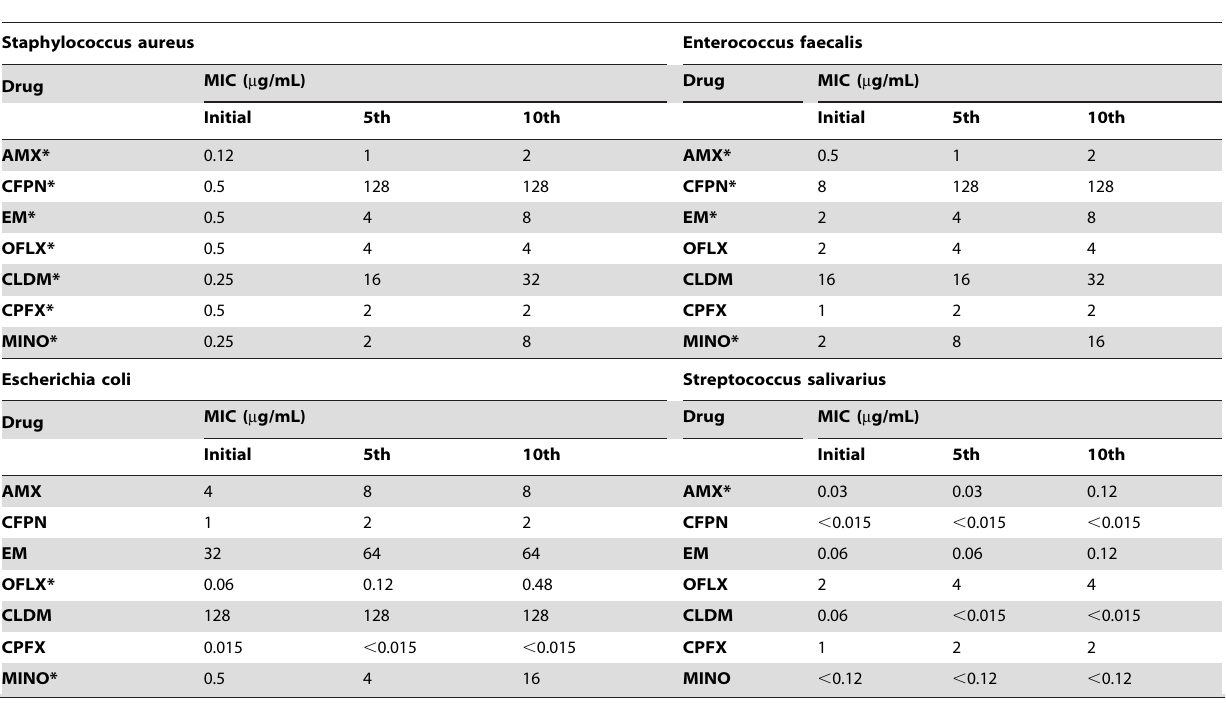
Table 1. MICs on the first, fifth, and tenth exposure of each bacterial species to antibacterial agents.